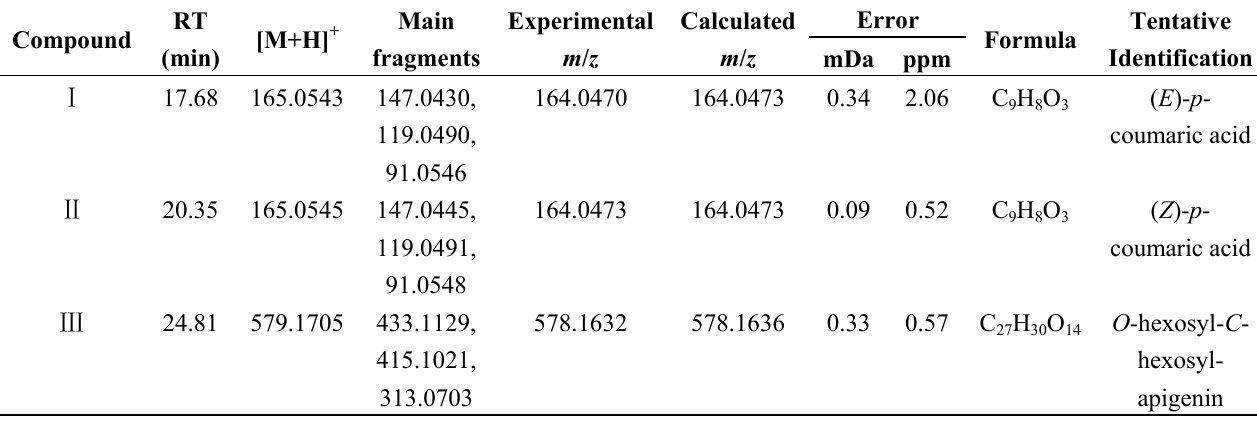
Table 2. MS data and the identification results of three compounds from dosed plasma (2.5 h) by LC-Q-TOF-MS. Compound Formula